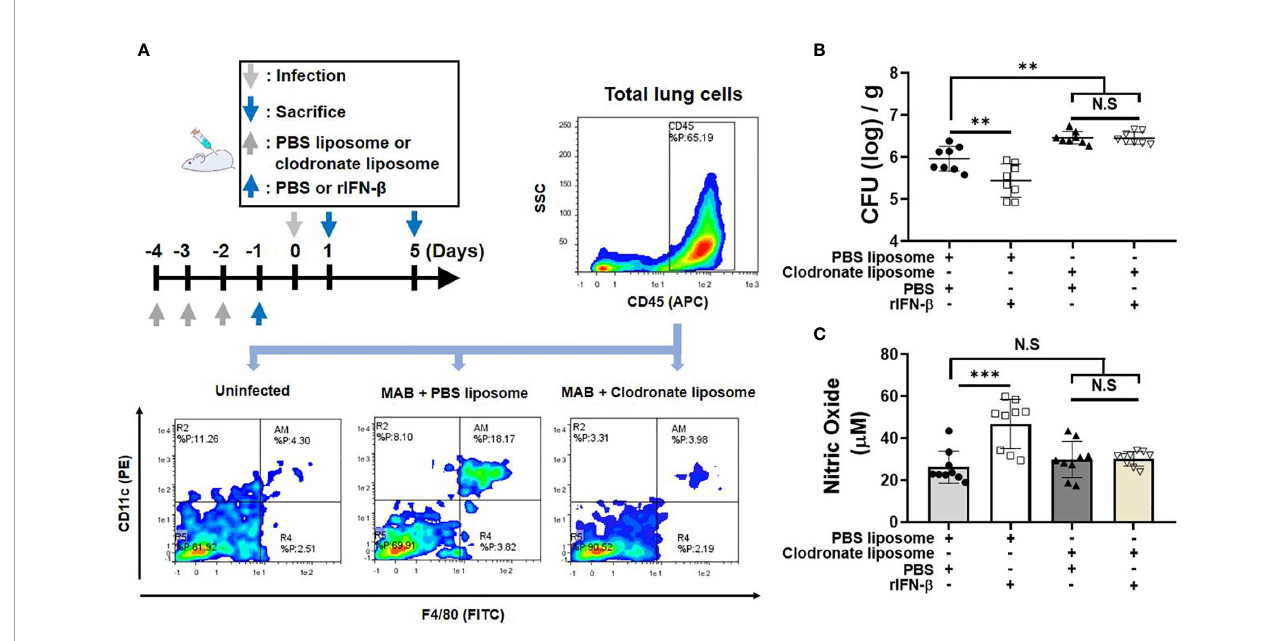
FIGURE 5 | Macrophages are responsible for rIFN- b response in MAB-induced NO production and the bacterial clearance in vivo . (A) The administration of reagents and bacterial infection were performed according to the schedule indicated in the diagram. Flow cytometric plot showing the population of CD45 + CD11c + F4/80 + alveolar macrophage in lung total cell at 1 day post infection. (B) Mice were administrated with indicated reagents intranasally under anesthesia. After 1 day, mice were infected with 2 × 10 7 CFU of MAB per mouse intranasally, and the bacterial loads in the lung lysate were determined at 5 days post infection. (C) Nitric oxide levels were measured on 1 day post infection in the lung lysate supernatant. (A) The results are one representative data of two independent experiments (n = 4). (B, C) The results are merged data of two independent experiments (n = 4 – 5) (**p < 0.01, ***p < 0.001). MAB, Mycobacterium abscessus ; CFU, colony-forming unit. NS, Not Statistically Signi fi